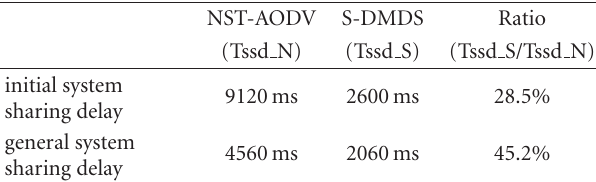
Table 3: Simulation result of system sharing delay in state scenario